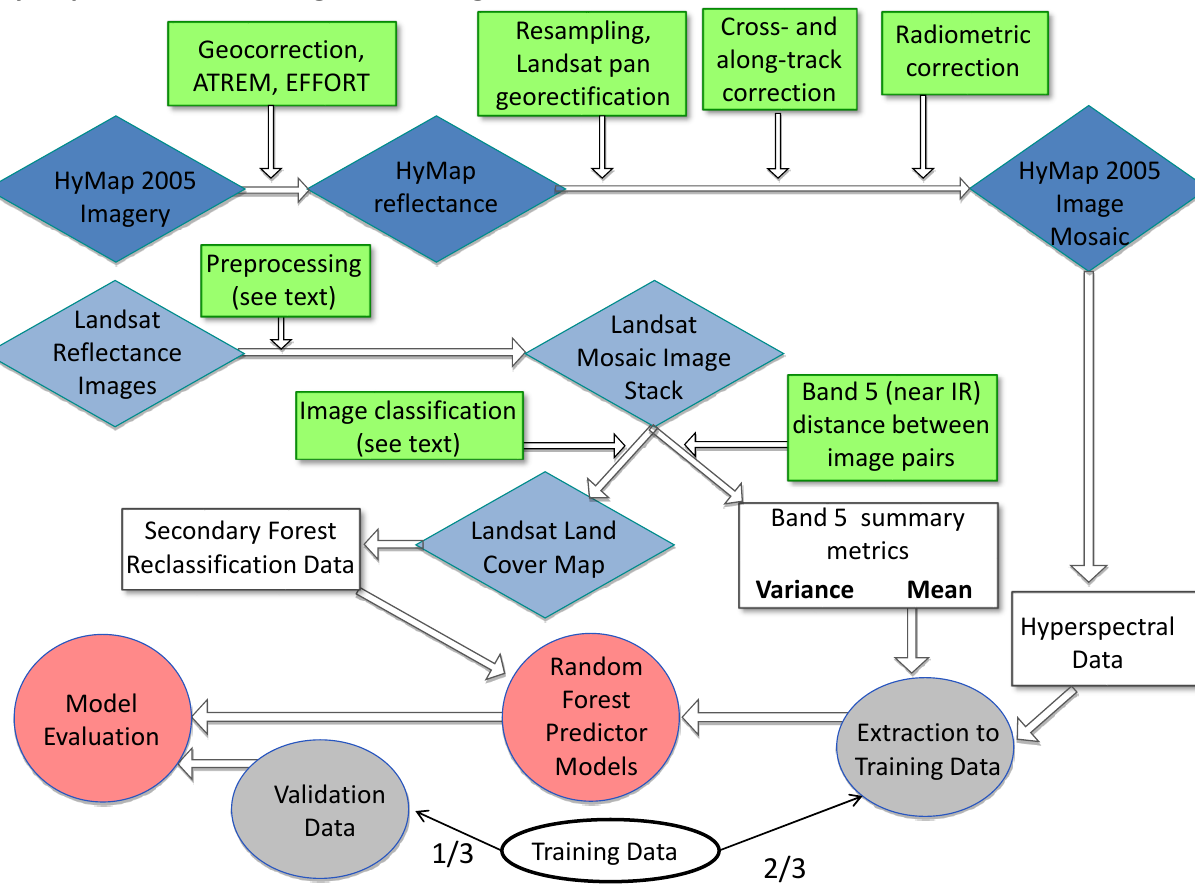
Figure 2. Flow diagram of pre-processing and processing steps. Blue diamonds denote images, green squares mark image processing, white boxes and circles denote data derived from images or field work, grey circles mark randomly selected, independent testing and training data, and red circles mark analysis